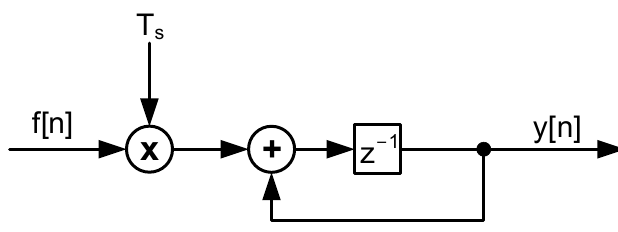
Figure 7. Improved block diagram of integration approximation.